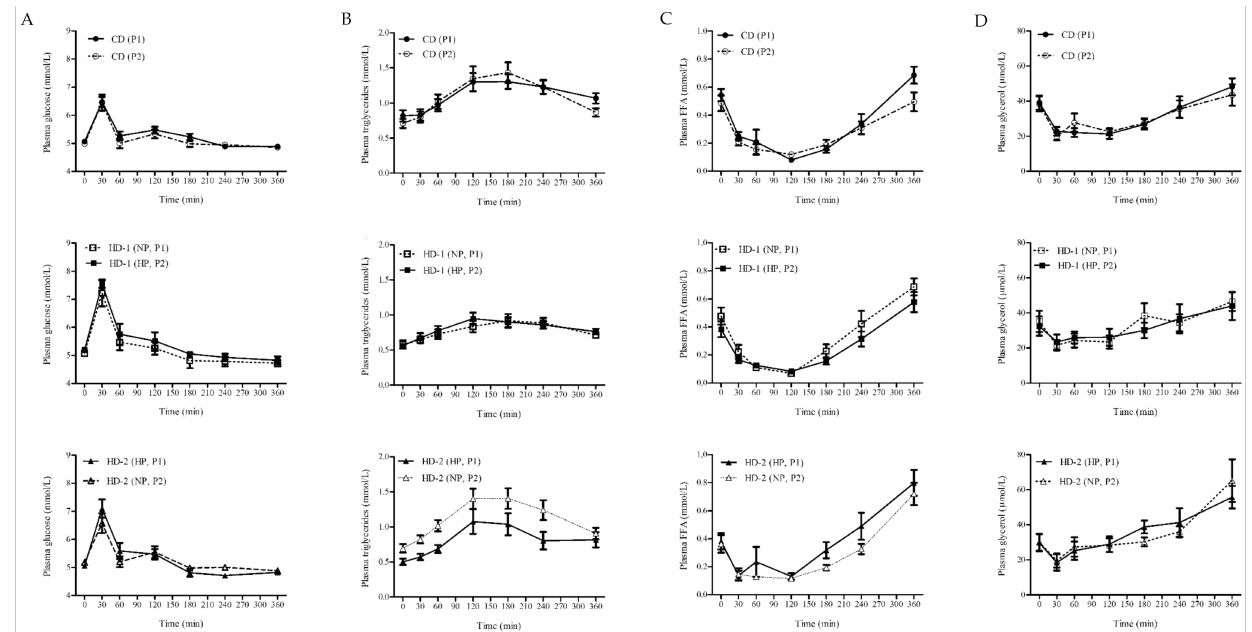
Figure 2. Response AUC of plasma during the meal challenge of: ( A ) glucose; ( B ) triglycerides (TG); ( C ) free fatty acids (FFA) and( D ) glycerol, in all dietary groups; participants where adapted to either a control diet (CD) for 4 weeks ( n = 10) or a high fat hypercaloric diet (HD) differing in protein content, normal (NP) vs. high (HP) in random order (NP-HP), n = 8; HP-NP, n = 9), P1 and P2. Data are mean ± standard error